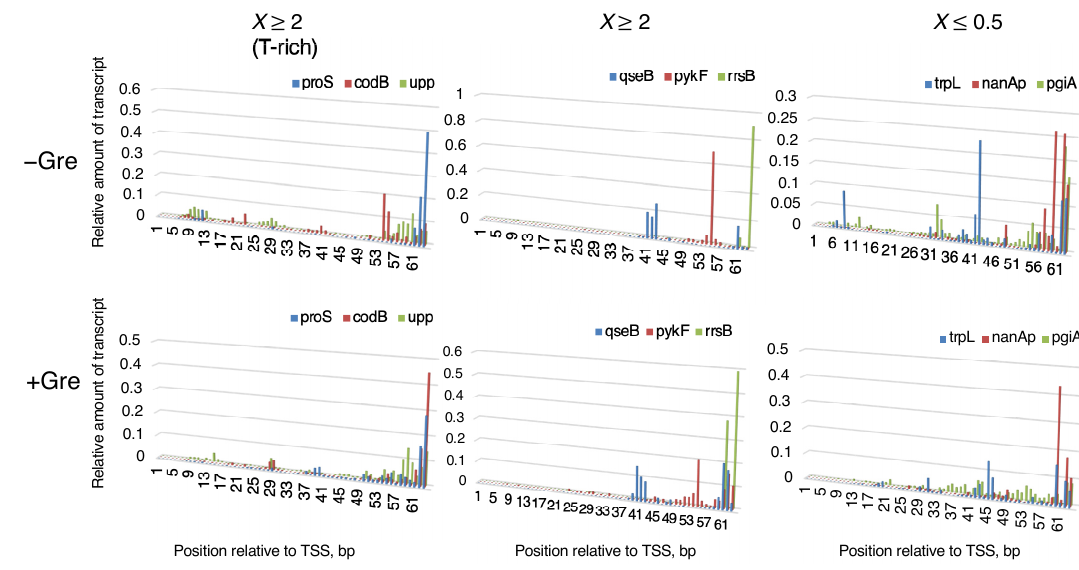
Figure 7. In vitro single-round transcription from 9 di ff erent promoters shown in Figure 6B. Entire transcription profiles at 20 min incubation with NTPs are shown in the presence (bottom) or absence (top) of GreAB. See the legend of Figure 6 for the categorization of